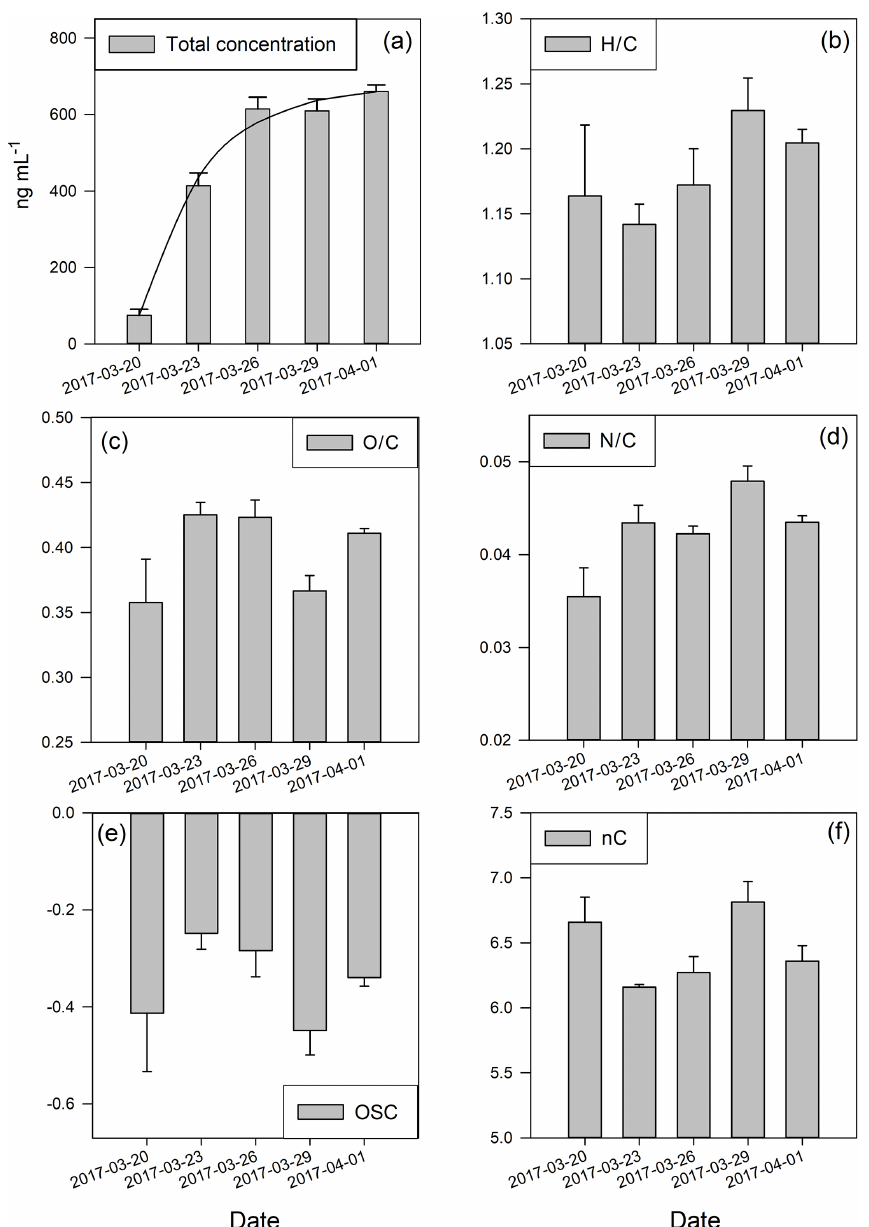
Figure 2. Total concentration of organic ions and cumulative metrics of atomic ratio distribution. (a) Total concentration in nanograms per millilitre; the line represents the fit from the simple deposition model explained in the text (Eq. 1); (b) H / C ratio; (c) O / C ratio; (d) N / C ratio; (e) oxidative state of carbon; (f) mean numbers of carbon. The error bars represent the standard deviation of three